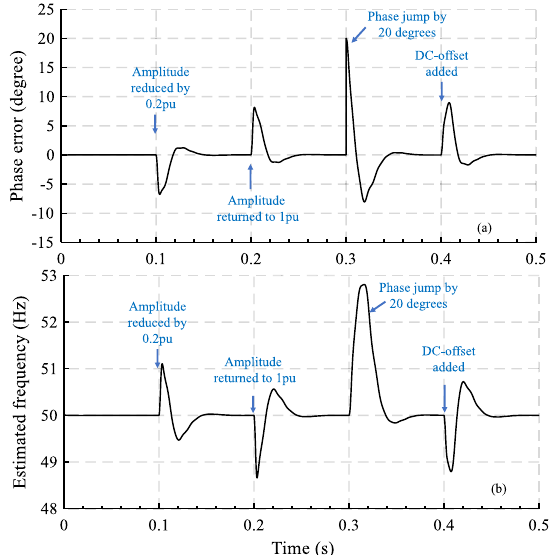
Fig. 5 Results of case study 1 grid conditions. a Estimated phase error and b estimated grid frequency